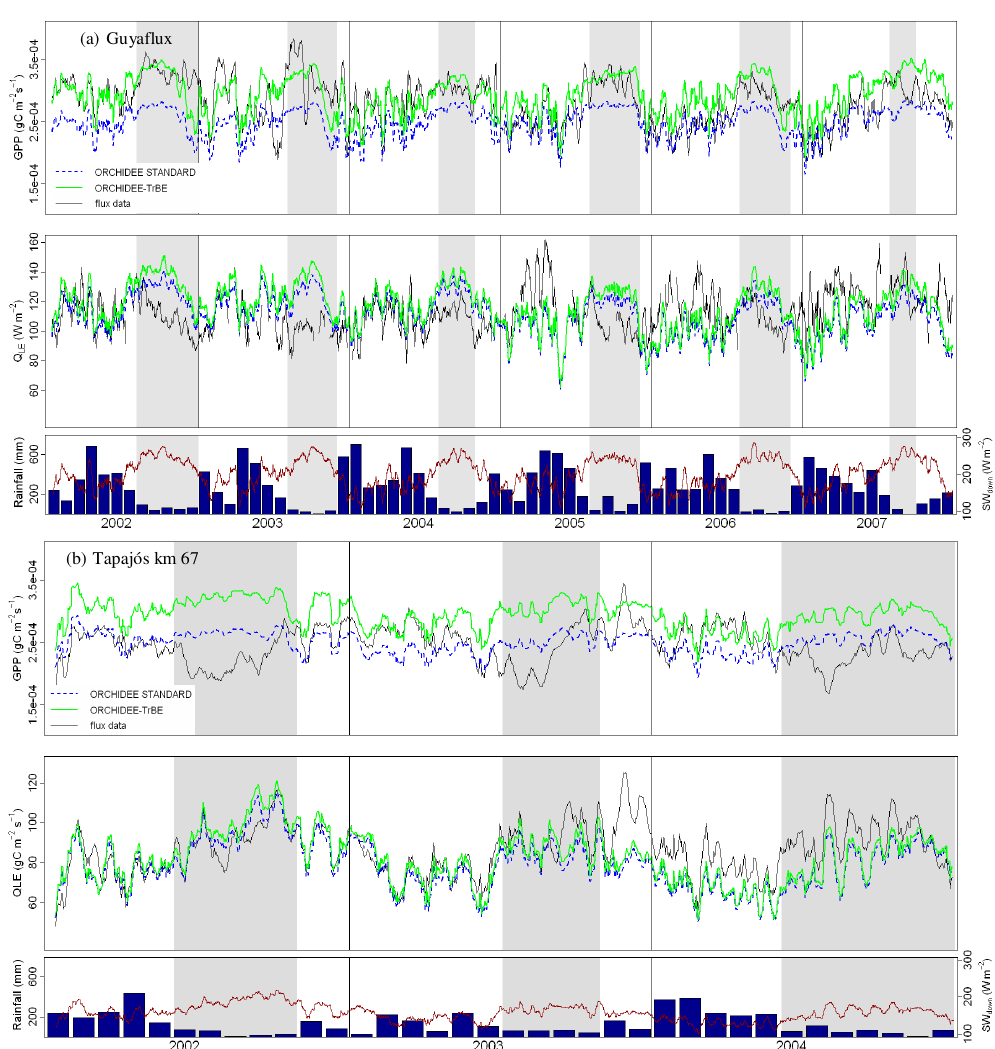
Run-sequence 10-day moving averages at (a) Guyaflux and (b) Tapaj´os (km 67) including daytime data (08:00h–16:00h) of Figure 8. Run-sequence 10 day moving averages at (a) Guyaflux and (b) Tapajós km 67 including daytime data (8h-16h) of measured and modelled GPP and QLE 30 along with daily running mean shortwave downward radiation (SWdown) and monthly rainfall. measured and modelled GPP and Q LE 30 along with daily running mean shortwave downward radiation SW down and monthly Dry periods are shaded in grey ( < 100mmmonth − 1 rainfall. Dry periods are shaded in gray (<100 mm month -1 ).